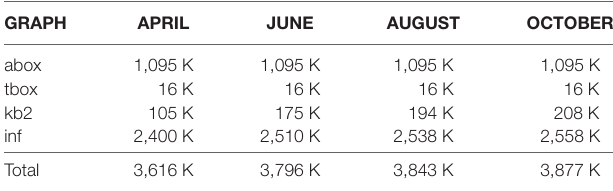
TAble 2 | Number of triples in graphs in OpenVIVO by month, April–October 2016.